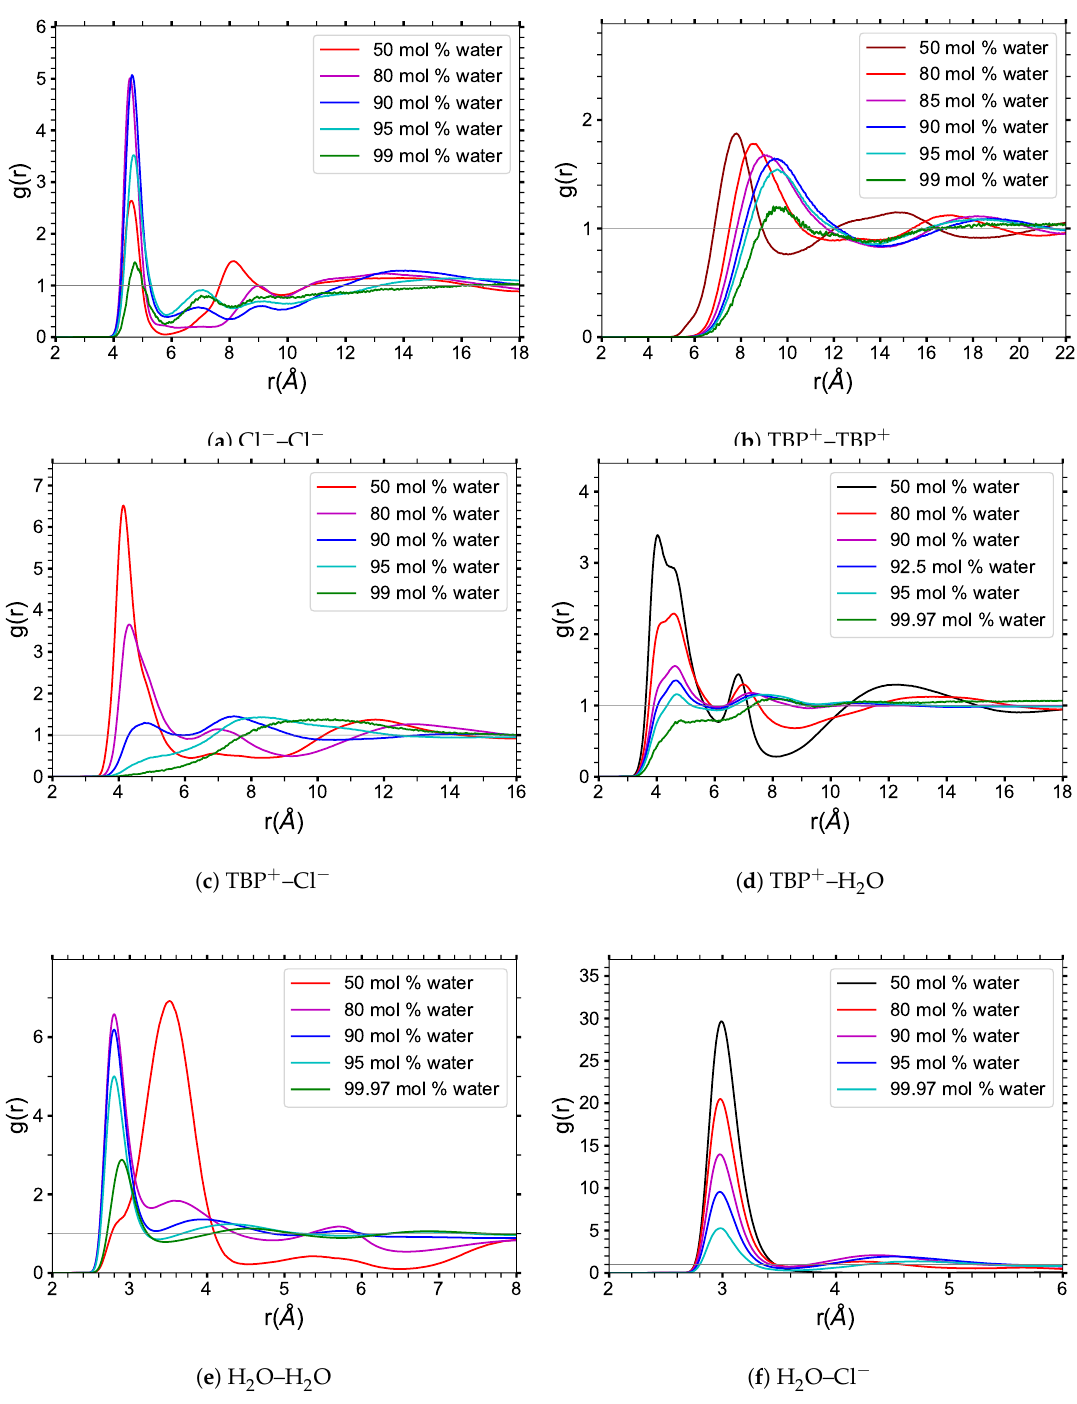
Figure A1. Radial distribution functions of TBPCl–water at 300K for various indicated water concentrations. The radial distribution functions are between the following molecules: ( a ) Cl − –Cl − ; ( b ) TBP + –TBP + ; ( c ) TBP + –Cl − ; ( d ) TBP + –H